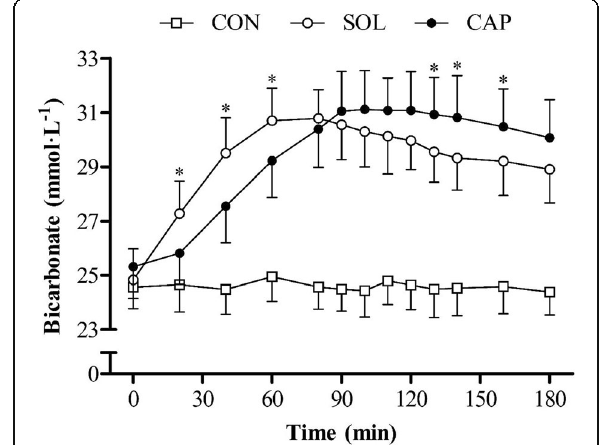
Fig. 1 Incidence ( a ) and mean (±SD) severity ( b ) of GI symptoms. The asterisk denotes significant difference between SOL and CAP conditions ( P < 0.05)